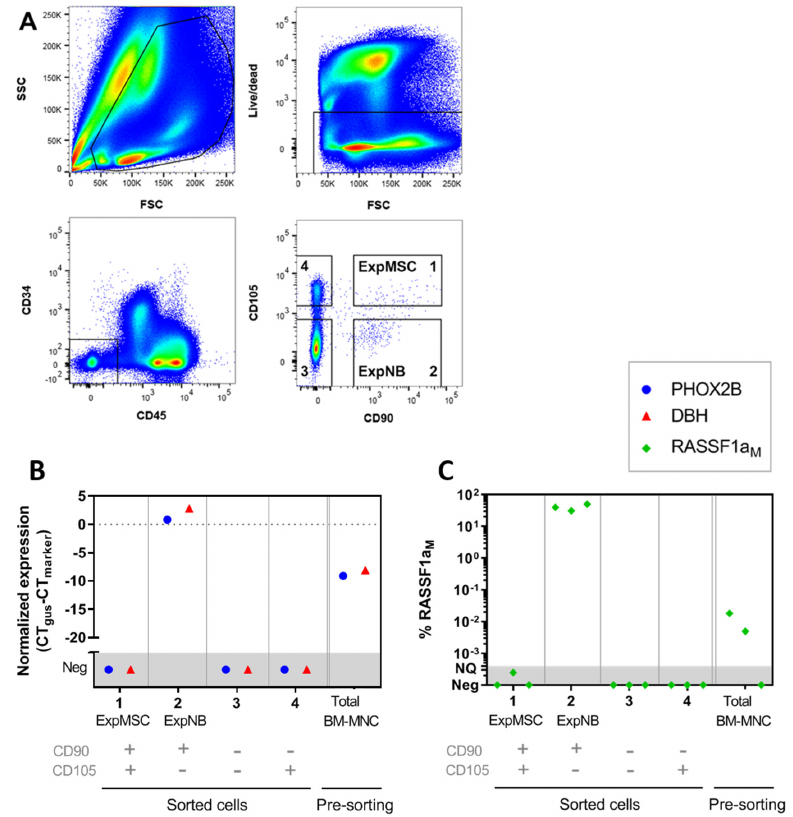
Figure 2. qPCR NB-marker testing in FACS-sorted cell populations proved that we can confidently discriminate between MSC and NB-cells in samples of metastatic-NB patients. ( A ) Representative plots to illustrate the gating strategy for isolating MSCs from bone marrow mononuclear cells (BM-MNCs) of a patient with metastatic-NB. Cells of population #1 express the classical MSC-markers CD90 and CD105, and are therefore expected to all belong to the MSC compartment (ExpMSC). Population #2 (CD90+ CD105 − ) is expected to contain NB-cells (ExpNB). ( B , C ) Testing of NB-marker expression by qPCR ( B ) PHOX2B and DBH ; analyzed in triplicate on BM of a metastatic NB patient; ( C ) methylated RASSF1a ; analyzed in triplicate on BM of 3 metastatic NB patients. All three NB-markers were detected in sorted NB-cells, but not in the MSC population. For RNA markers ( PHOX2B and DBH ): b-glucuronidase ( GUSB ) was used for normalization (normalized Ct (deltaCt) = Ct GUSB − Ct marker). For DNA marker RASSF1aM : qPCRs were performed specific for its methylated ( RASSF1aM ) and unmethylated ( RASSF1aU ) status. The percentage of RASSF1a methylation was defined as: [ RASSF1aM ]/([ RASSF1aM + RASSF1aU ]). qPCR reactions were carried out at least in duplicate and mean values were used. Neg = negative, NQ = not quantifiable.